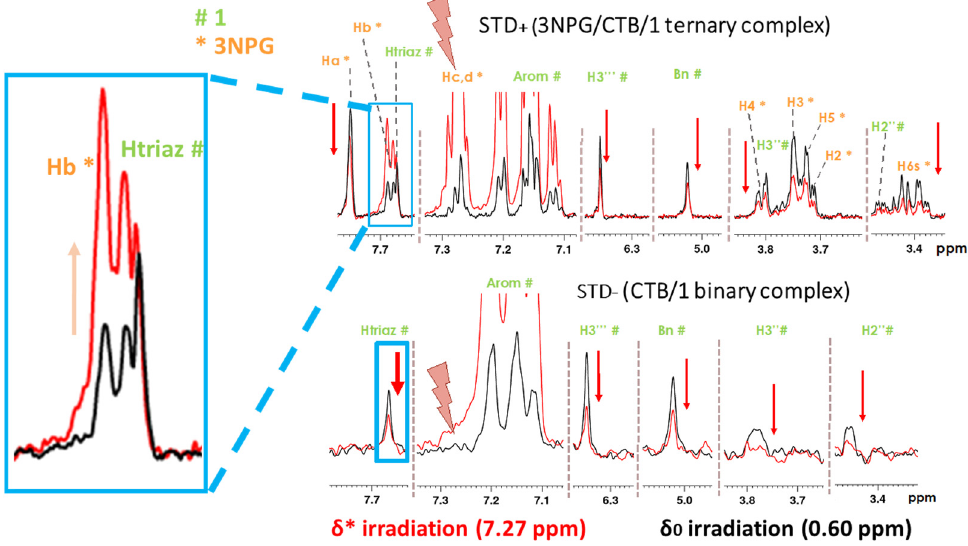
Figure 5. IL-STD difference spectra of ( Top ): the ternary complex 3NPG/CTB/ 1 (STD ∗ + and STD 0 + ) and ( Bottom ): the control binary complex CTB/ 1 in the absence of 3NPG (STD ∗ − and STD 0 − ), with irradiation at δ 0 = 0.6 ppm (in black) and at δ * = 7.27 ppm, on resonance at the frequency of protons Hc and Hd of 3NPG (in red). The assignment of all peaks is given and the signal of Htriaz is squared in turquoise and magnified on the left, showing the increased intensity when irradiating at δ * = 7.27 ppm, whereas all the other protons (with the exceptions discussed in the main text) decreased their intensities. A saturation time of 2 s was employed, and a line broadening factor of 0.3 Hz was applied to the FID before FT.